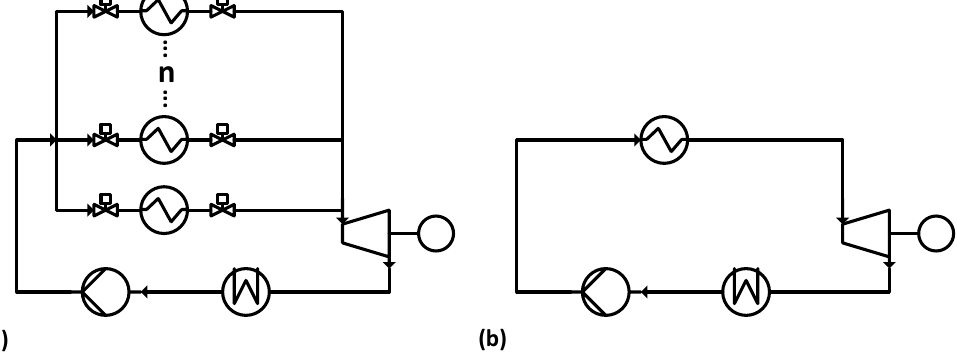
Figure 2. Process flow diagram of ( a ) the basic Misselhorn cycle and ( b ) a simple